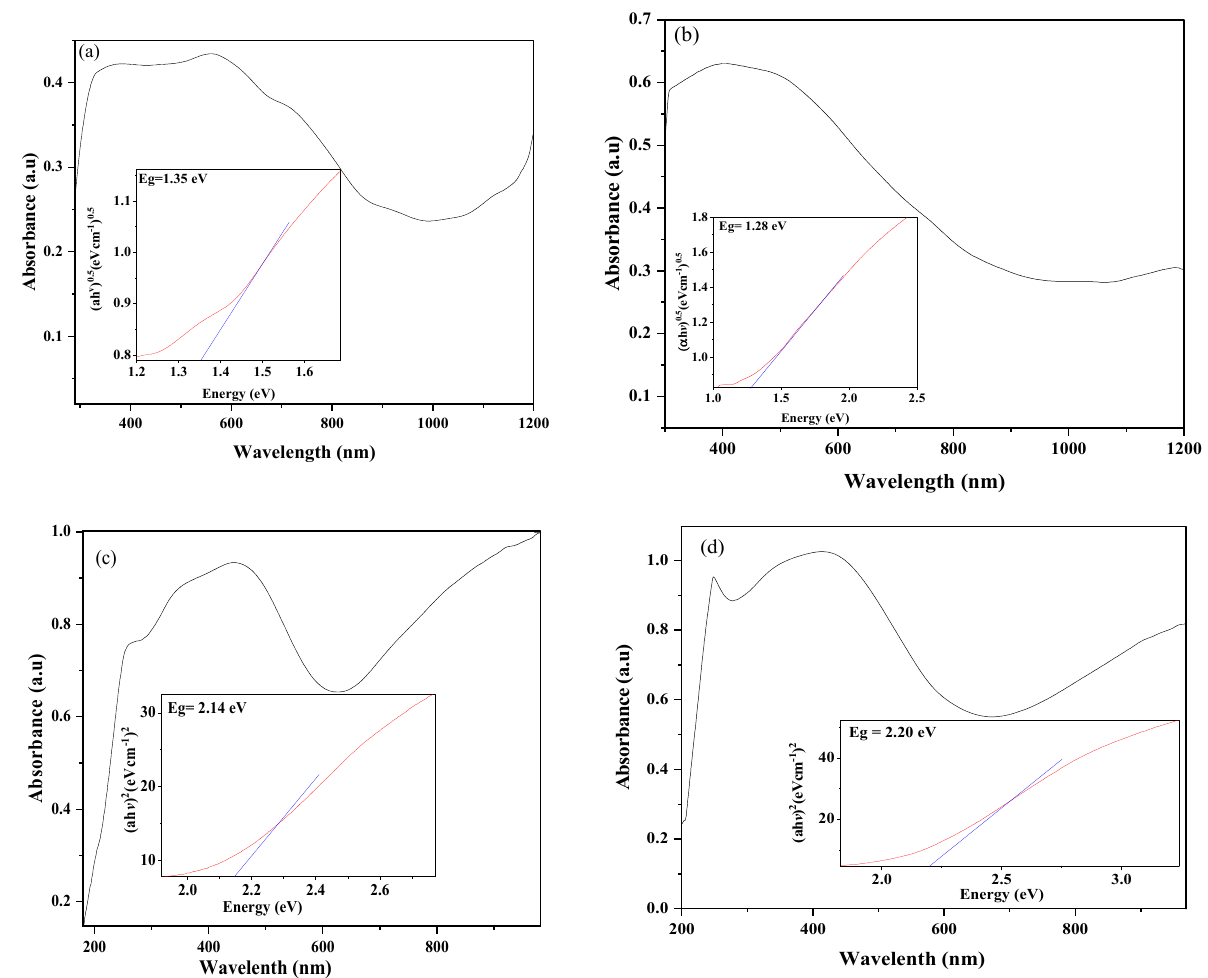
Figure 4. UV-vis-NIR spectra of ( a ) Cu 31 S 16 (120 ◦ C), ( b ) Cu 31 S 16 (150 ◦ C), ( c ) Cu 7 S 4 (220 ◦ C), and ( d ) Cu 7 S 4 (250 ◦ C). The insets are the respective Tauc plots .